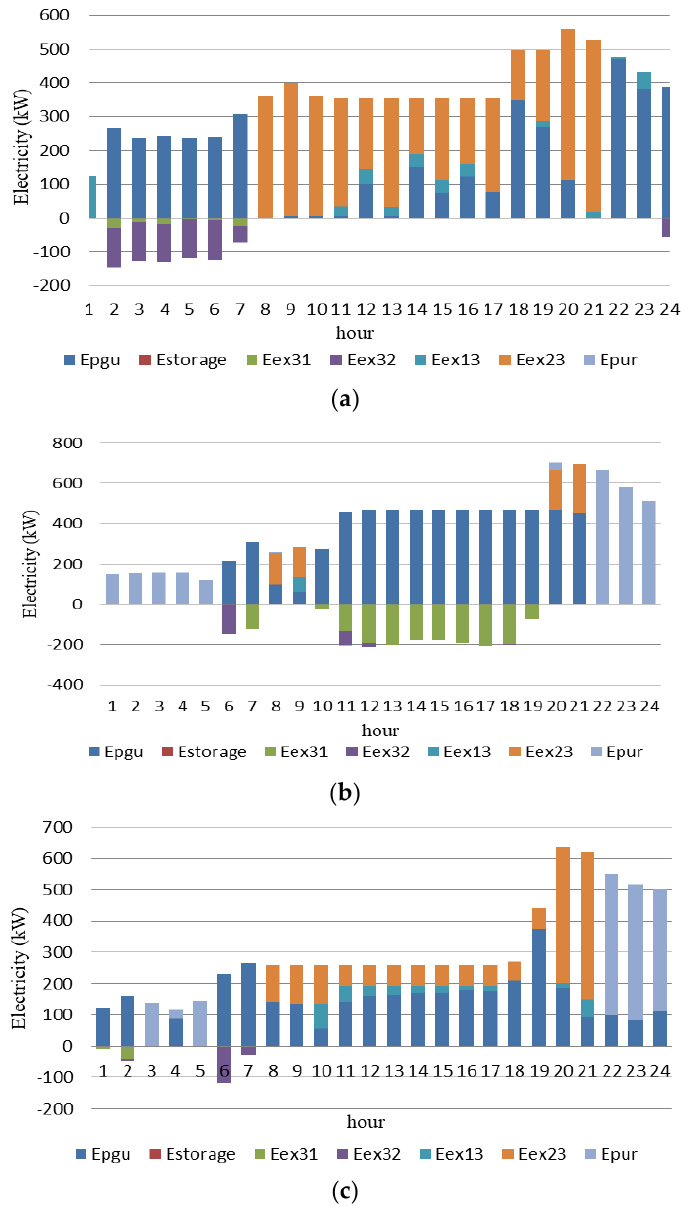
Figure 8. Hourly electricity balance of residential building in typical winter ( a ), summer ( b ) and mid-season days ( c ).